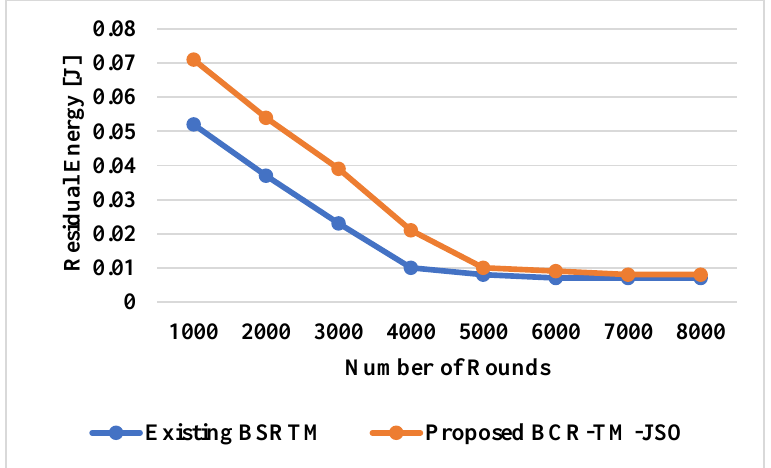
Figure 9. Performance of lifetime in terms of residual energy with existing BSRTM [21].